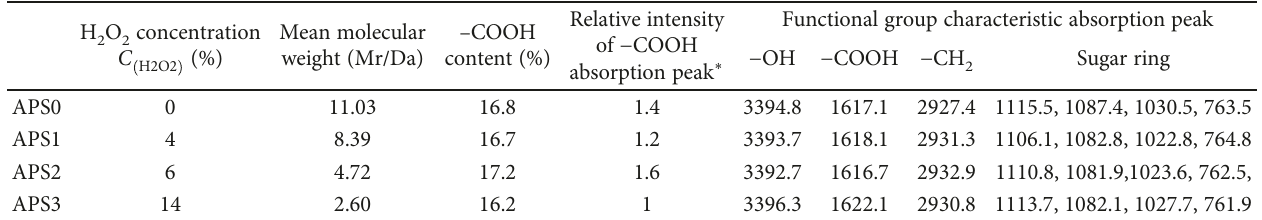
Functional group characteristic absorption